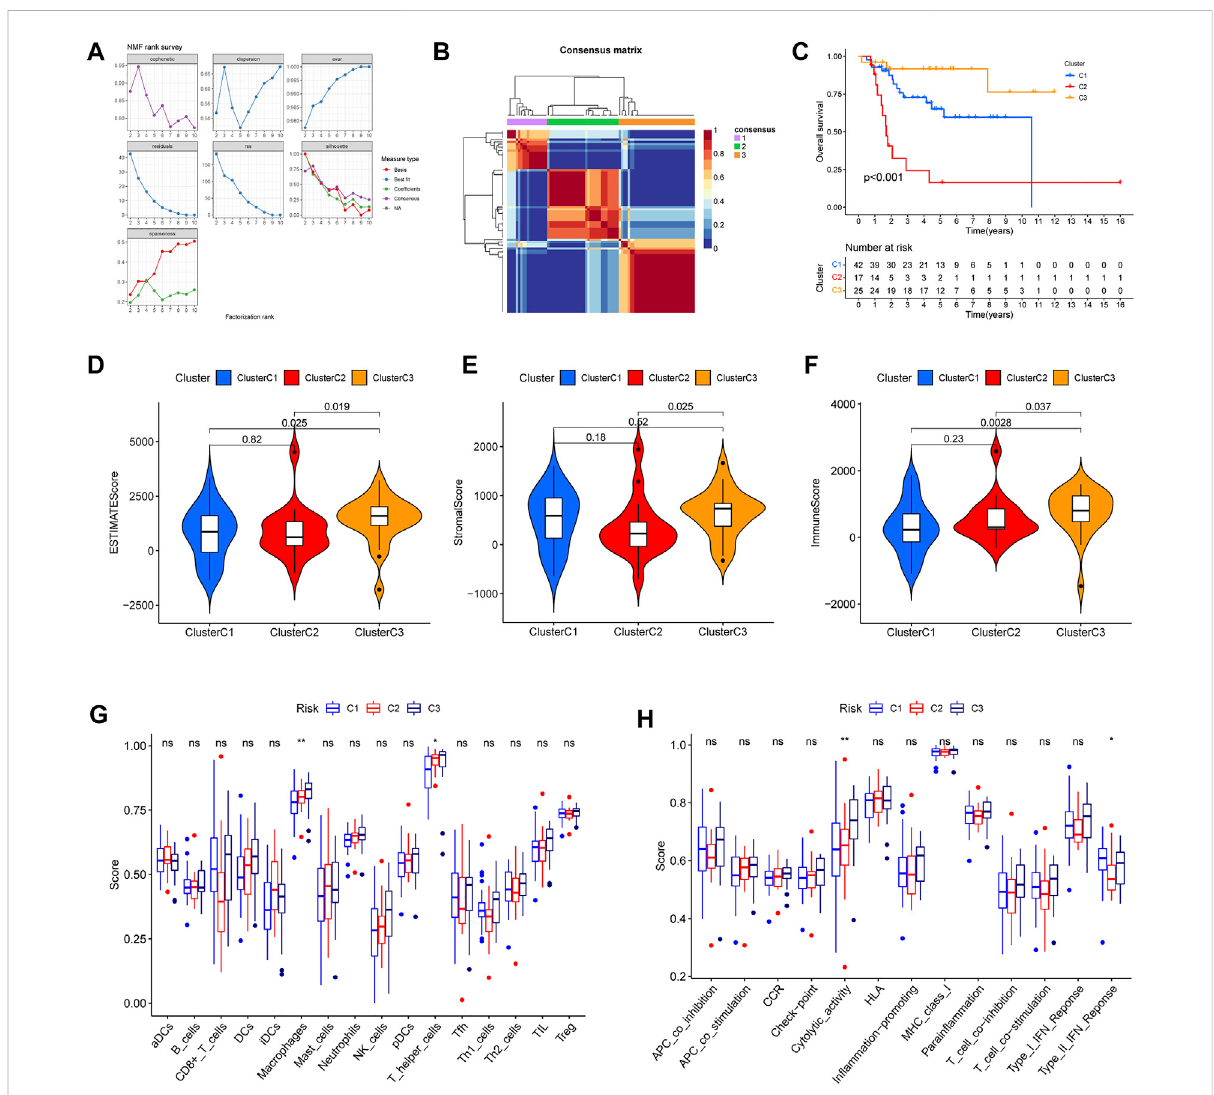
FIGURE 9 Different immune microenvironment and immune-related functions in the osteosarcoma subtypes. (A) The value of the nonnegative matrix factorization (NMF). (B) The NMF clustering-based value of best cophenetic. (C) Kaplan – Meier curves of OS in the three clusters. (D – F) The ESTIMATE score, stromal score, and immune score of OS subtypes. (G) The percentage of immune cells in the three clusters. (H) The signi fi cant immune-related functions in the three